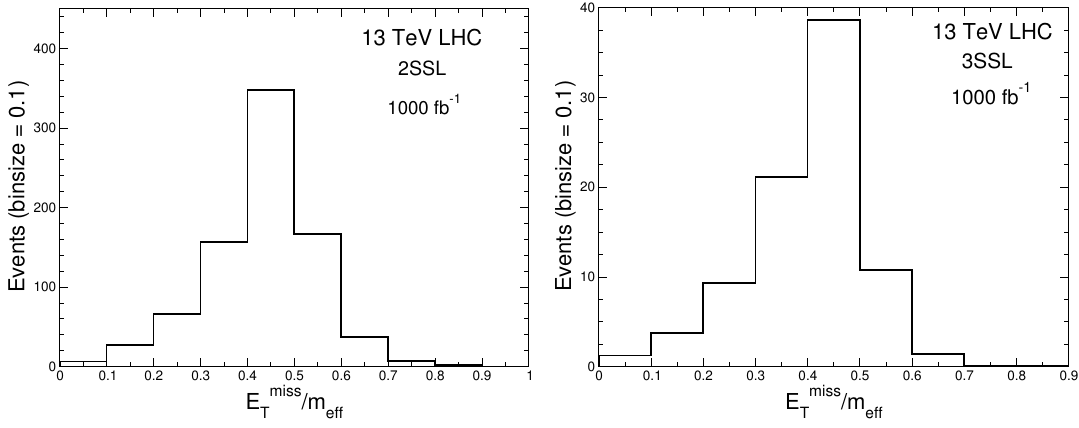
Figure 8 . The distribution of the ratio of the missing energy and the e(cid:11)ective mass ( E miss for signal events in the 2SSL (left panel) and 3SSL (right panel) channels at the 13 TeV LHC. The events are weighted for 1000 fb (cid:0) 1